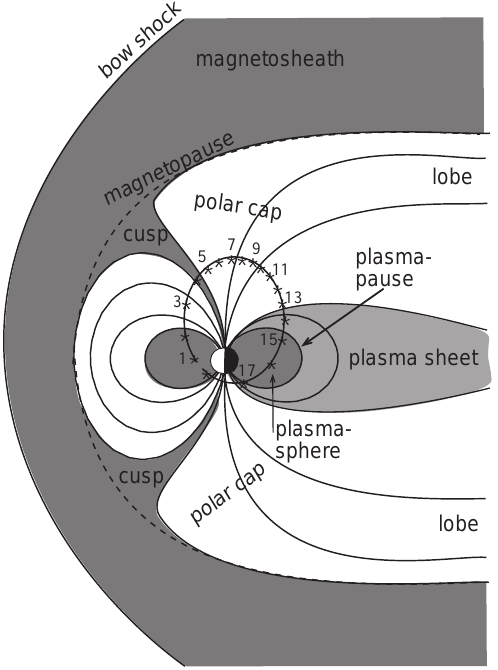
Fig. 1. Schematic drawing of the Earth’s magnetosphere in the noon-midnight meridian. A solid line presents a Polar trajectory; asterisks give the spacecraft’s position at one-hour